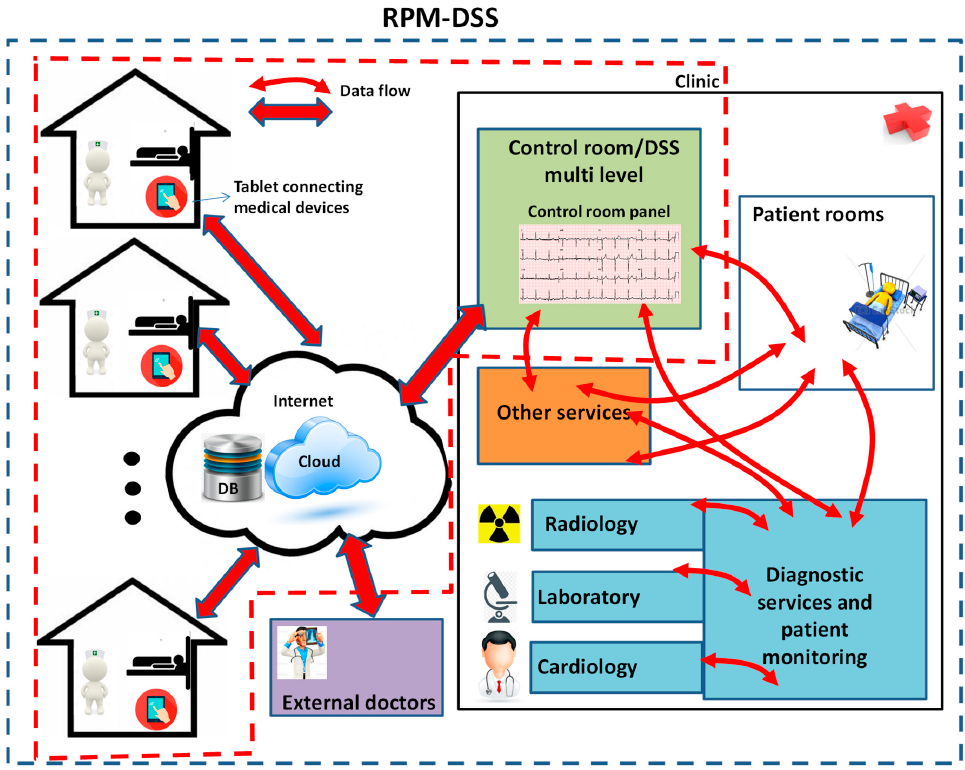
Figure 2. Architecture of the telemedicine platform: patients’ data flow as an evolution of the architecture proposed in Reference [14] (the red, dashed line embeds the developed prototype system).